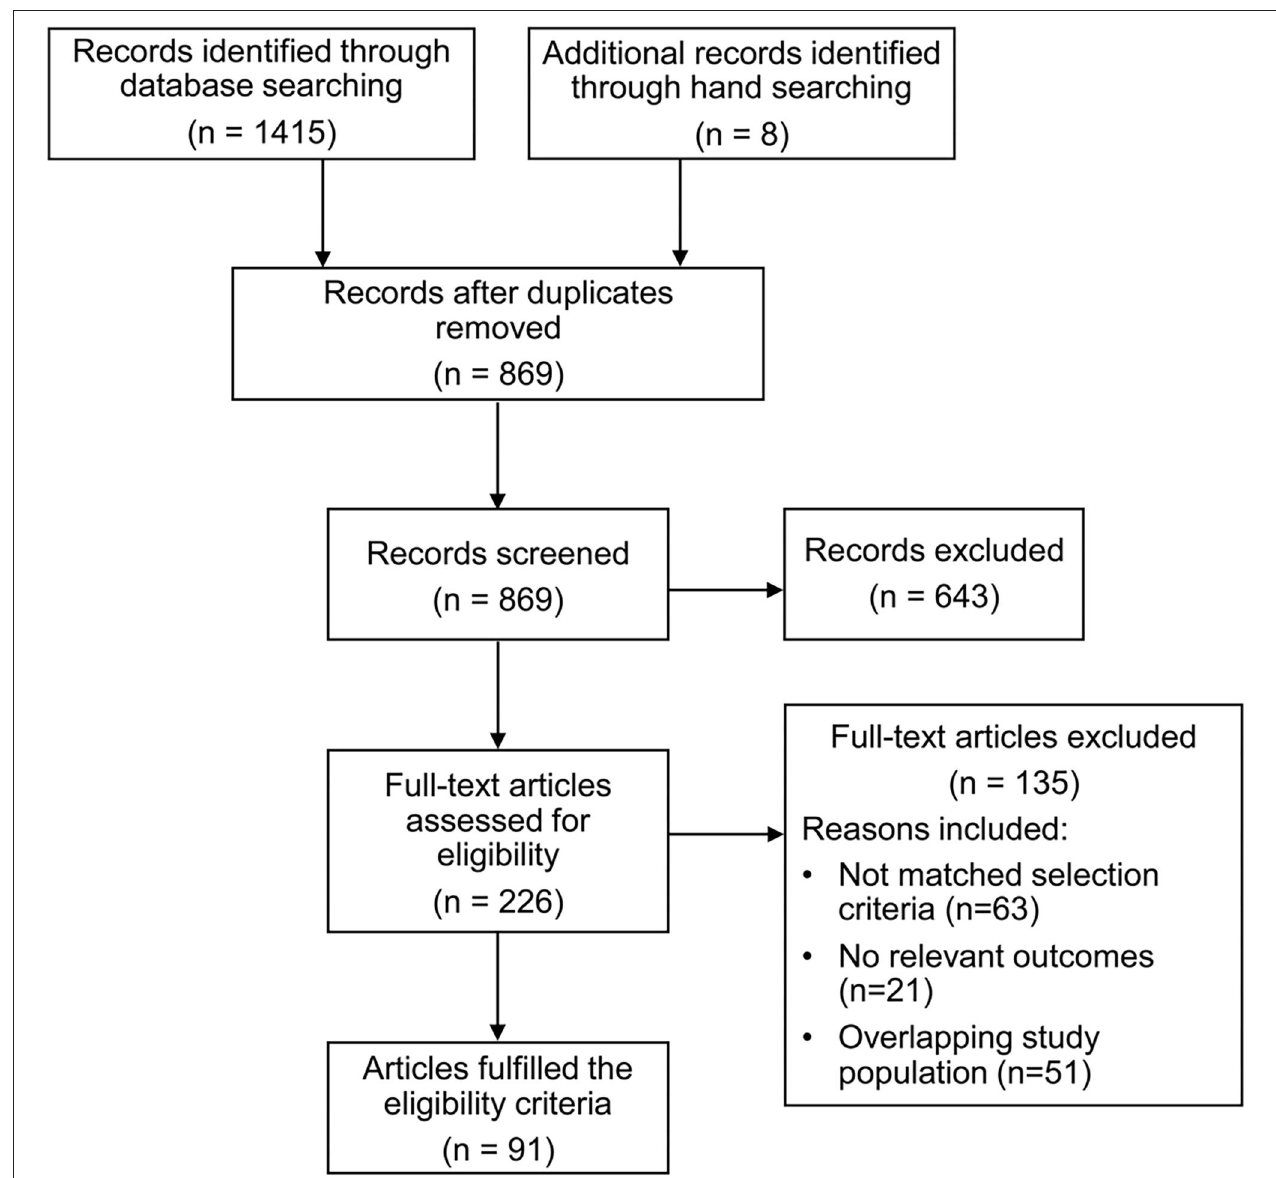
FIGURE 1 | Flowchart of study selection